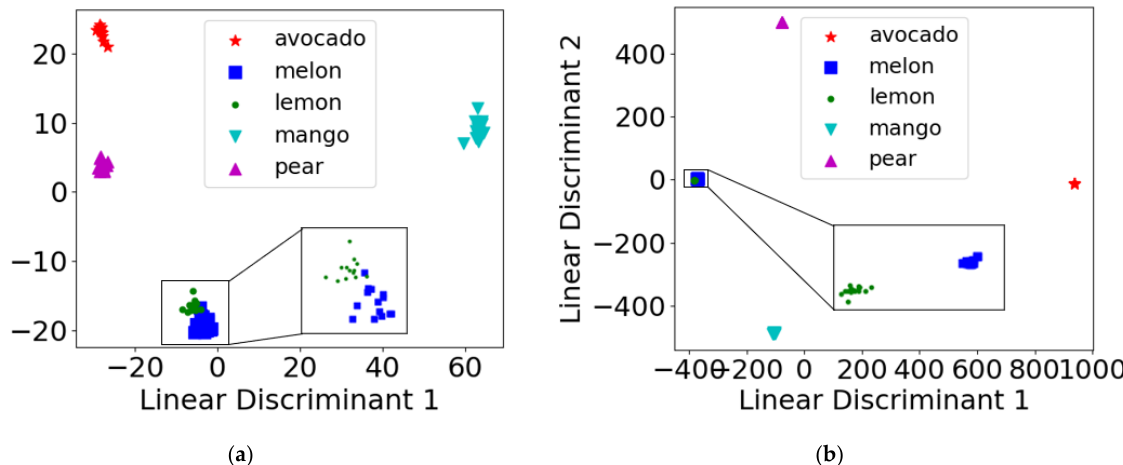
Figure 7. The LDA plot for sensor conductance responses of different types of fruits: ( a ) LDA plot for features extracted by equation (1) fitting, with linear discriminant 1 (LD1) accounting for 77.2% and linear discriminant 2 (LD2) accounting for 16.8%; ( b ) LDA plot for features extracted by 1D convolutional layers, with linear discriminant 1 accounting for 65.2% and linear discriminant 2 ac- counting for 27.0%.